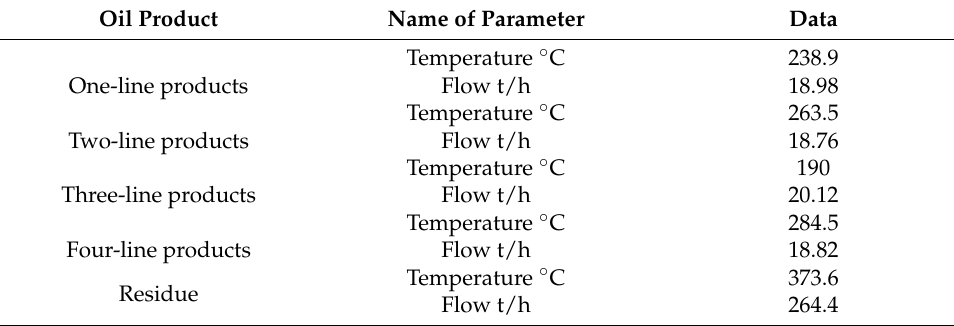
Table 4. The basic parameters of sideline products of the vacuum column.